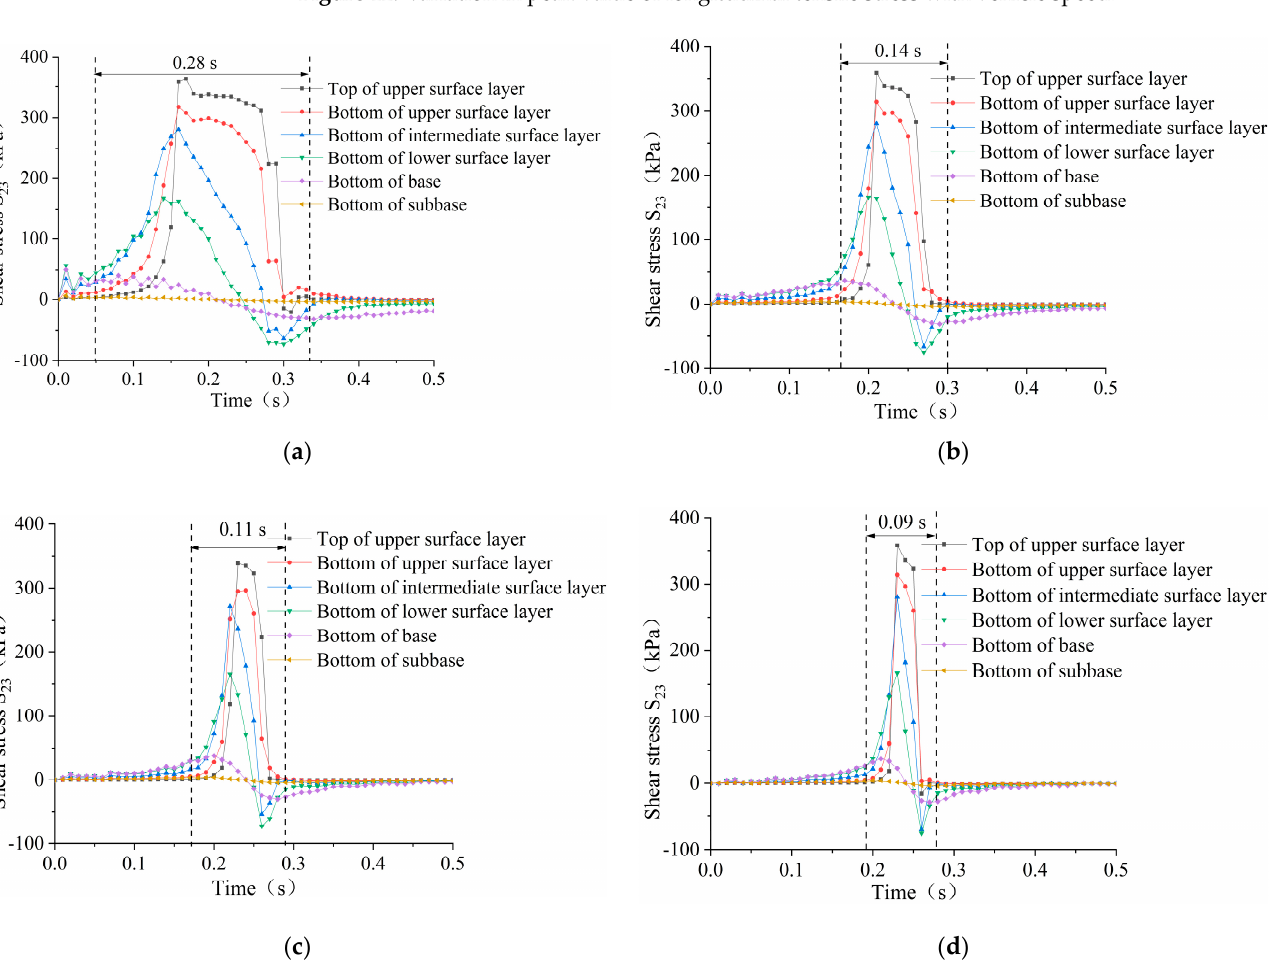
Figure 13. Variation in shear stress over time at initial speeds of ( a ) 10 km/h, ( b ) 20 km/h, ( c ) 30 km/h, and ( d ) 40 km/h.